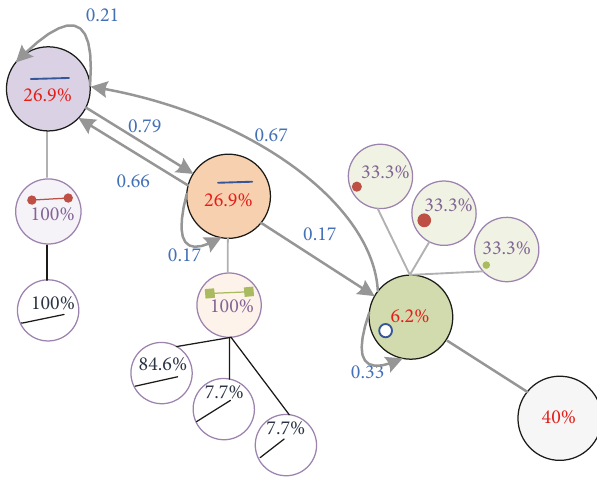
Figure 8: Individual travel behavior graph of passenger